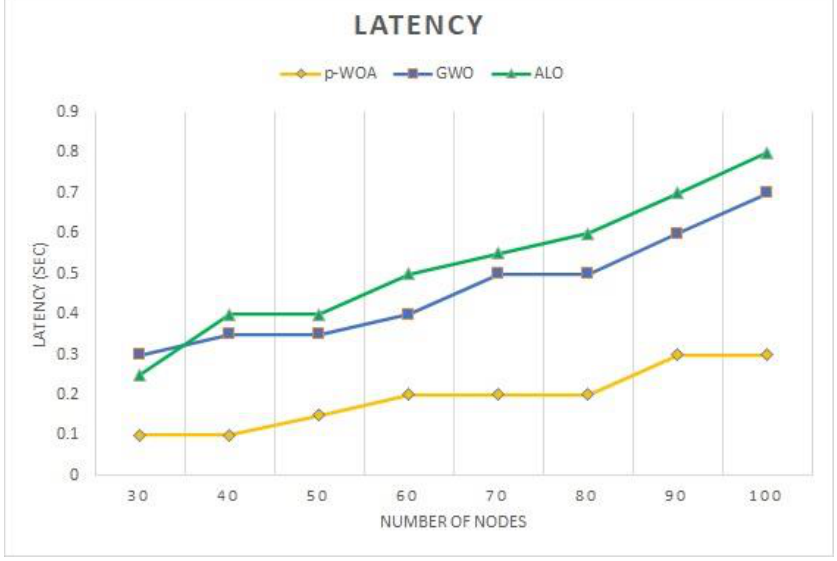
Figure 8. Latency for 30 – 100 Nodes .